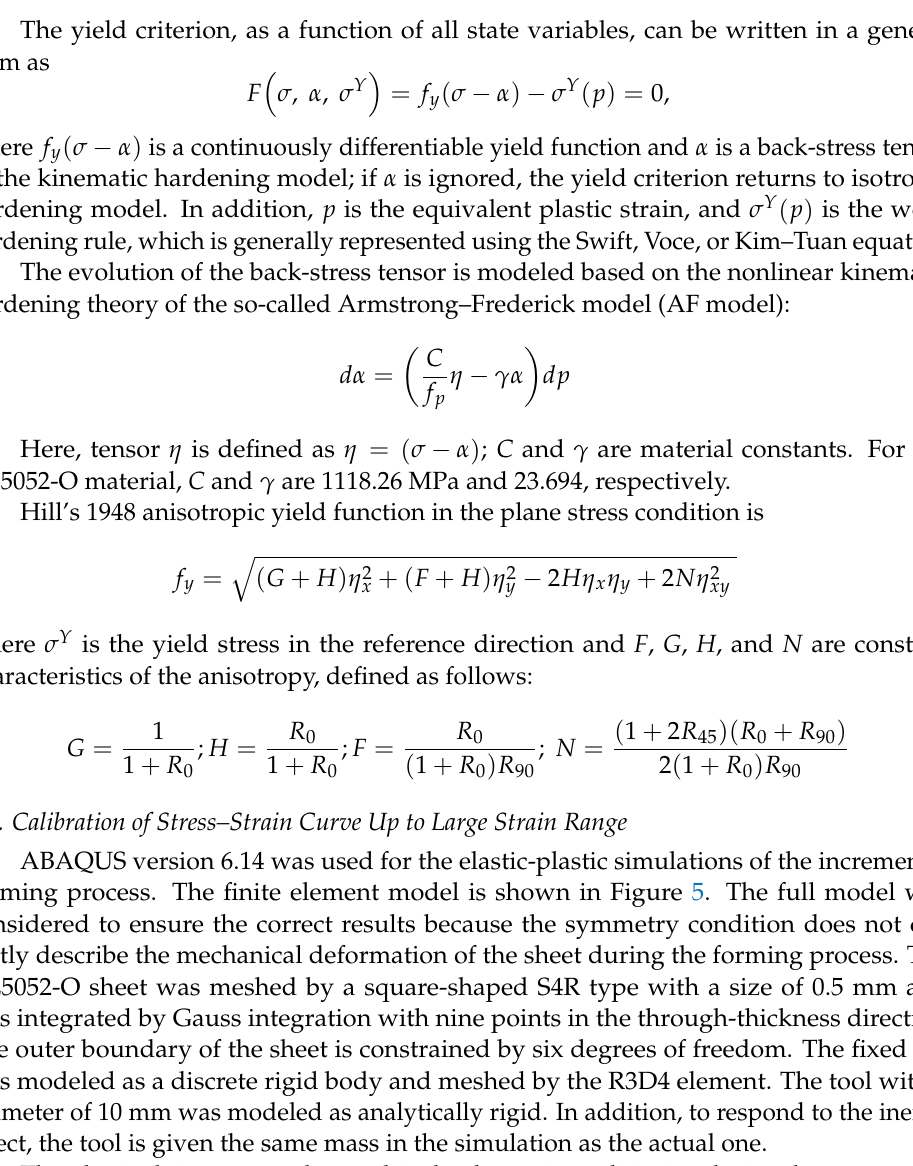
Table 2. Parameters of material AL5052-O. F G H N